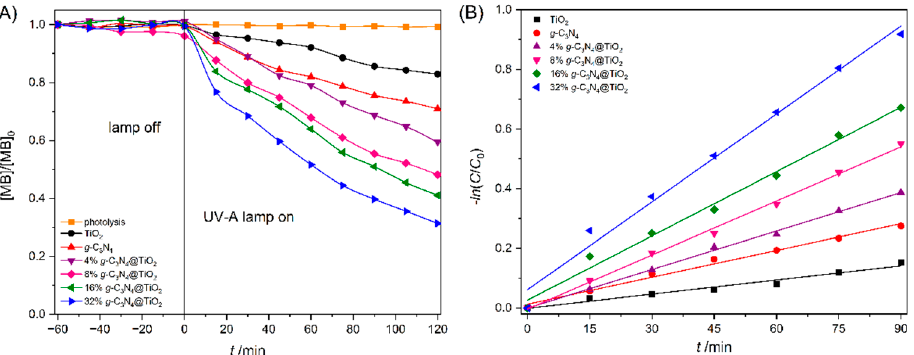
Figure 5. ( A ) Adsorption and photocatalytic activities of the prepared photocatalysts and ( B ) plotted first-order kinetics of MB degradation under UV-A irradiation (with wavelengths between 300 nm and 400 nm) with linear fits to obtain the rate